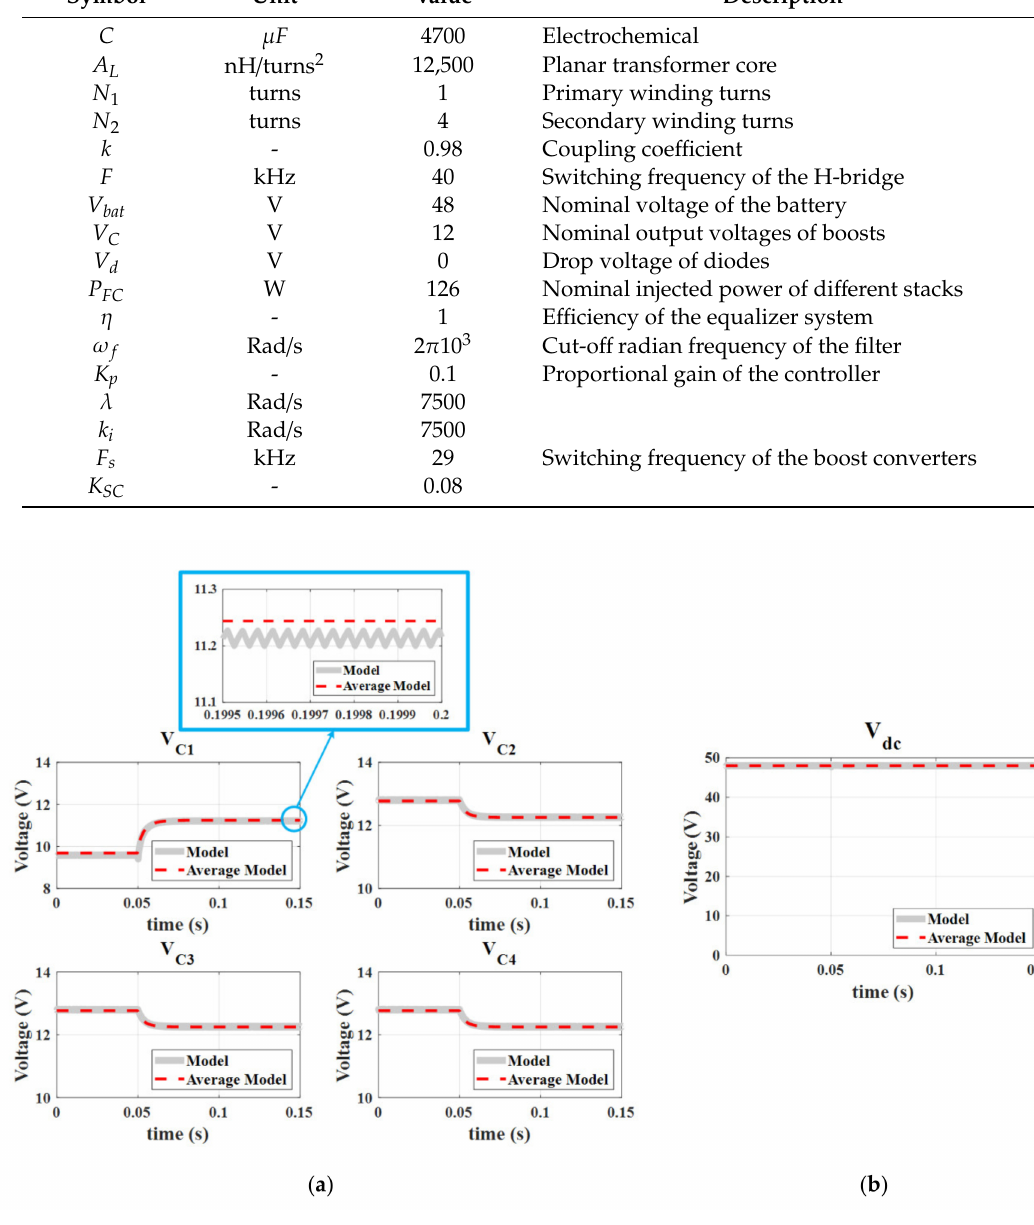
Figure 10. Simulation results in closed-loop when P 1 is increased from 63 to 100 W and the other stacks inject the nominal power: ( a ) Voltage changes of the boost converters output capacitors connected to the stacks; ( b ) DC bus